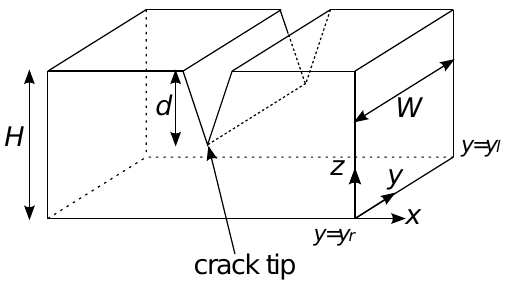
Figure 2. Crevasse shape. See Table A1 for a list of the parameters.